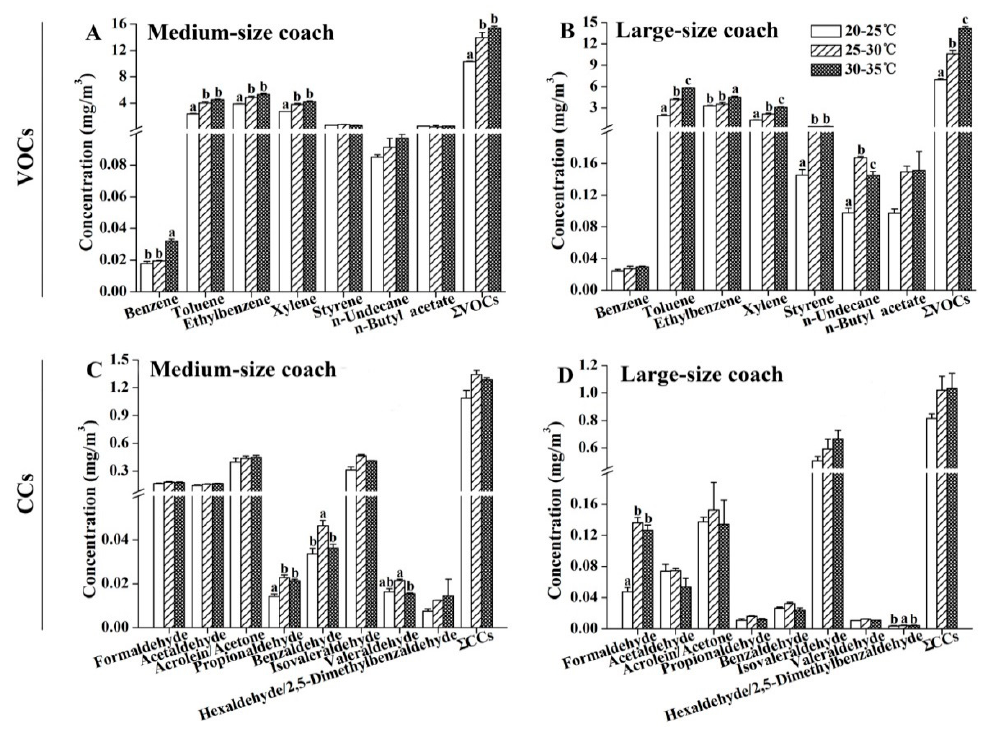
Figure 5. Emissions of organic compounds under different interior temperatures. ( A , B ) Levels of VOCs in the tested air samples; ( C , D ) Levels of CCs in the tested air samples. Interior relative humidity during sampling was 50% ± 10%. The results are expressed as the mean ± SEM. Values labeled with different letters are significantly different from each other at p < 0.05.